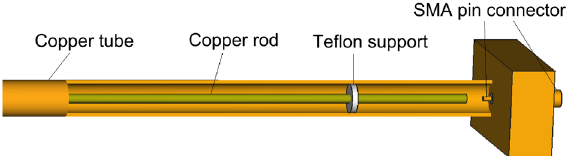
FIG. 13. Basic setup of the resonator method for impedance determination. A cut through the outer conductor (copper tube) shows the Teflon support and the capacitive coupling at one end of the